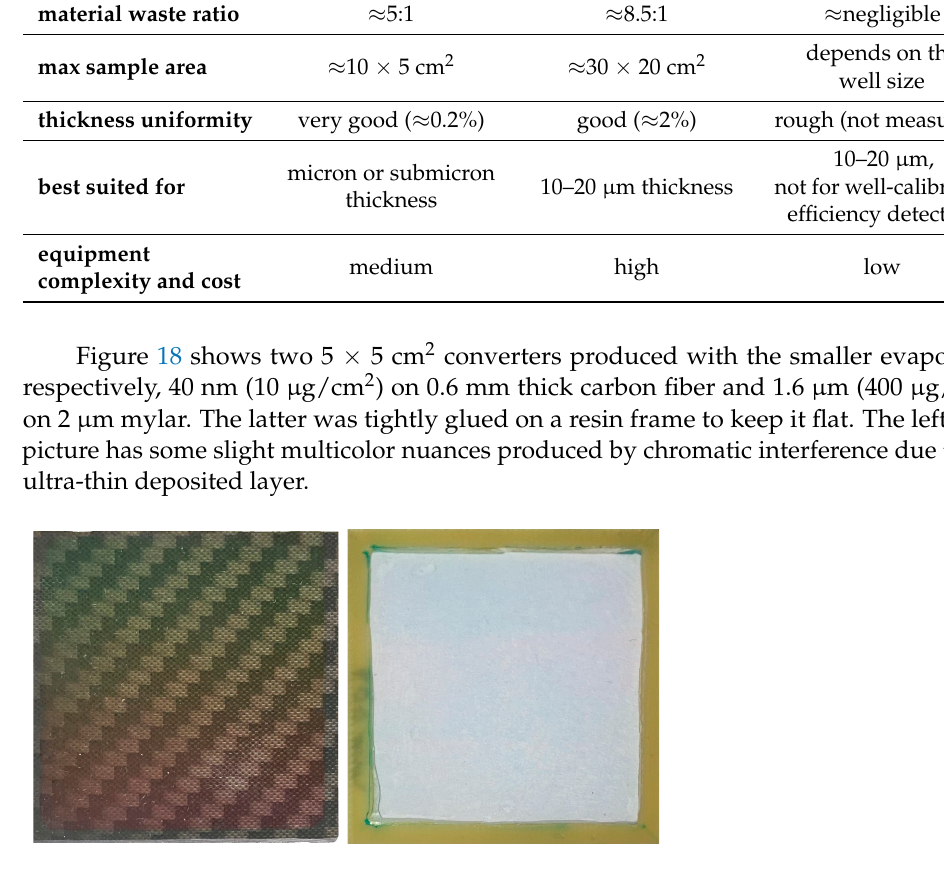
Table 3. Comparison of the main features for the three 6 LiF deposition methods.